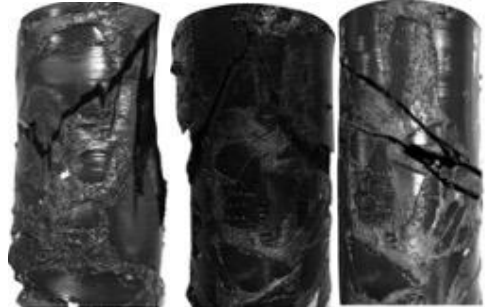
Figure 10. Damage patterns of the consolidated specimens.